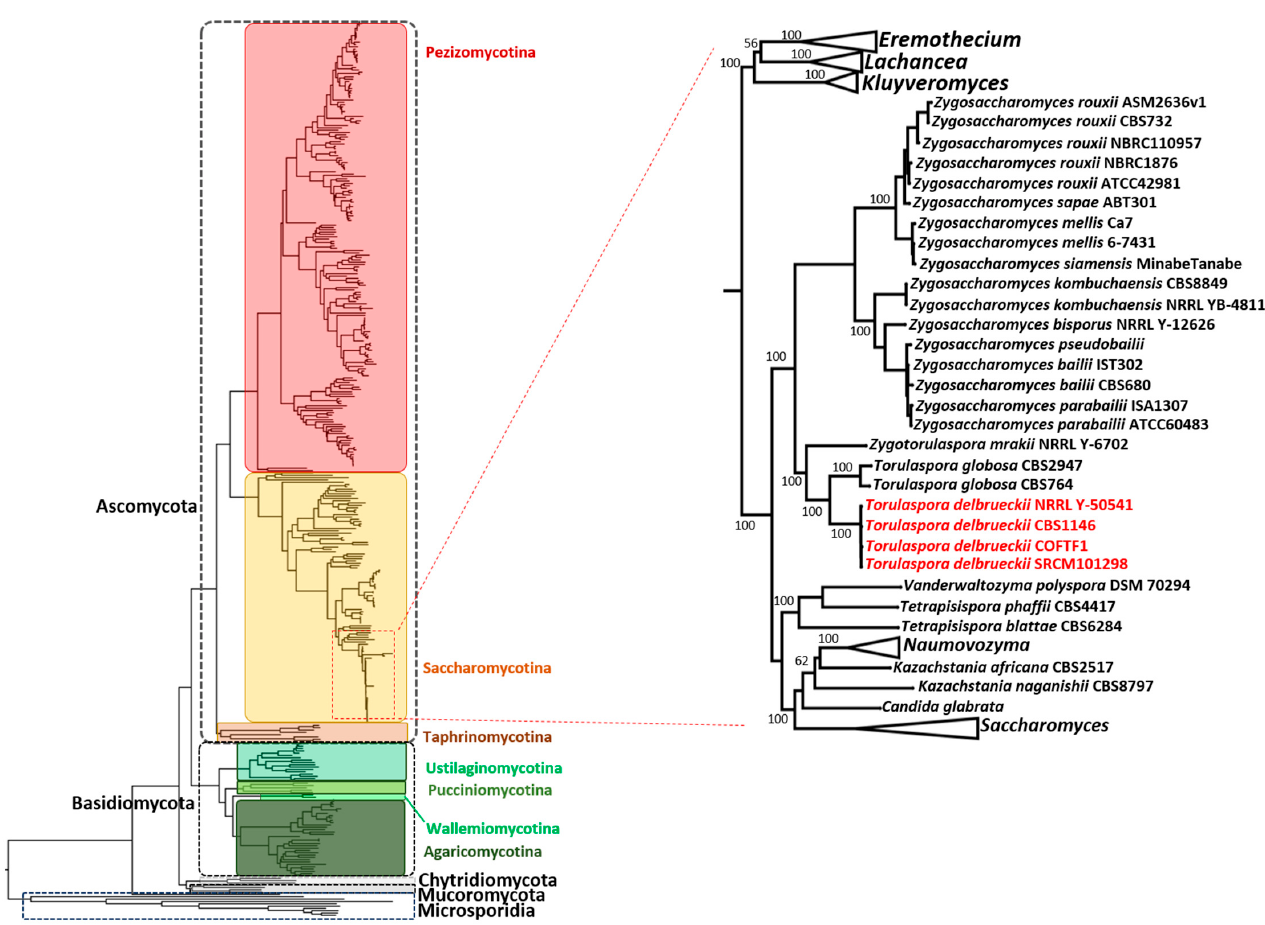
Figure 5. Phylogeny of fungi regarding 386 fungal core genomes (alignment of 204 common proteins). The phyla are highlighted using dashed lines and the subphyla are identified using colored boxes. The placements of the Torulaspora delbrueckii strains are shown in detail relative to the closely related species inside the Saccharomycotina subphylum. The concatenated alignment was used for the phylogenetic reconstruction by considering the maximum likelihood and 500 bootstrap replicates. The bootstrap values (in percentages) are shown for the highlighted branches. A detailed phylogenetic tree and the full bootstrap values are available in Supplementary Data S10.